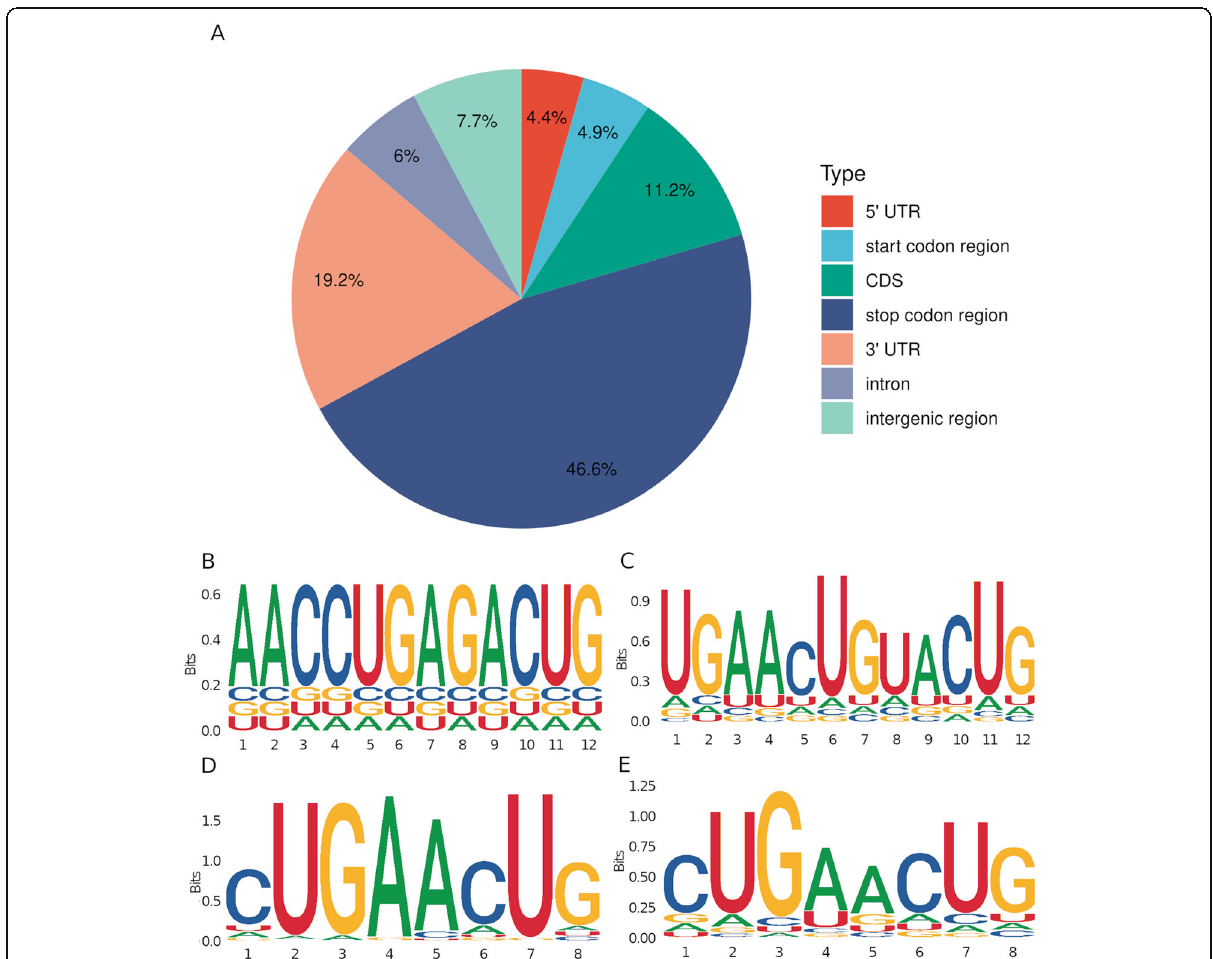
Fig. 2 Overview of m 6 A methylome in rice. ( A ) Annotation of identified m 6 A high confident peaks ( B ) - ( E ) canonical RRACH and motif URUAY motif in four